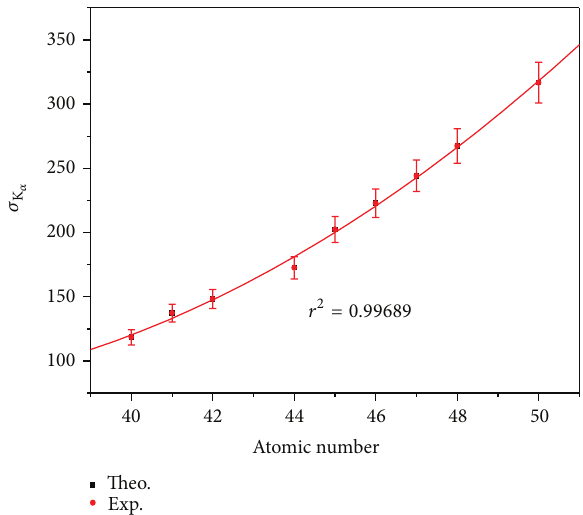
production cross sections as a K 𝛽